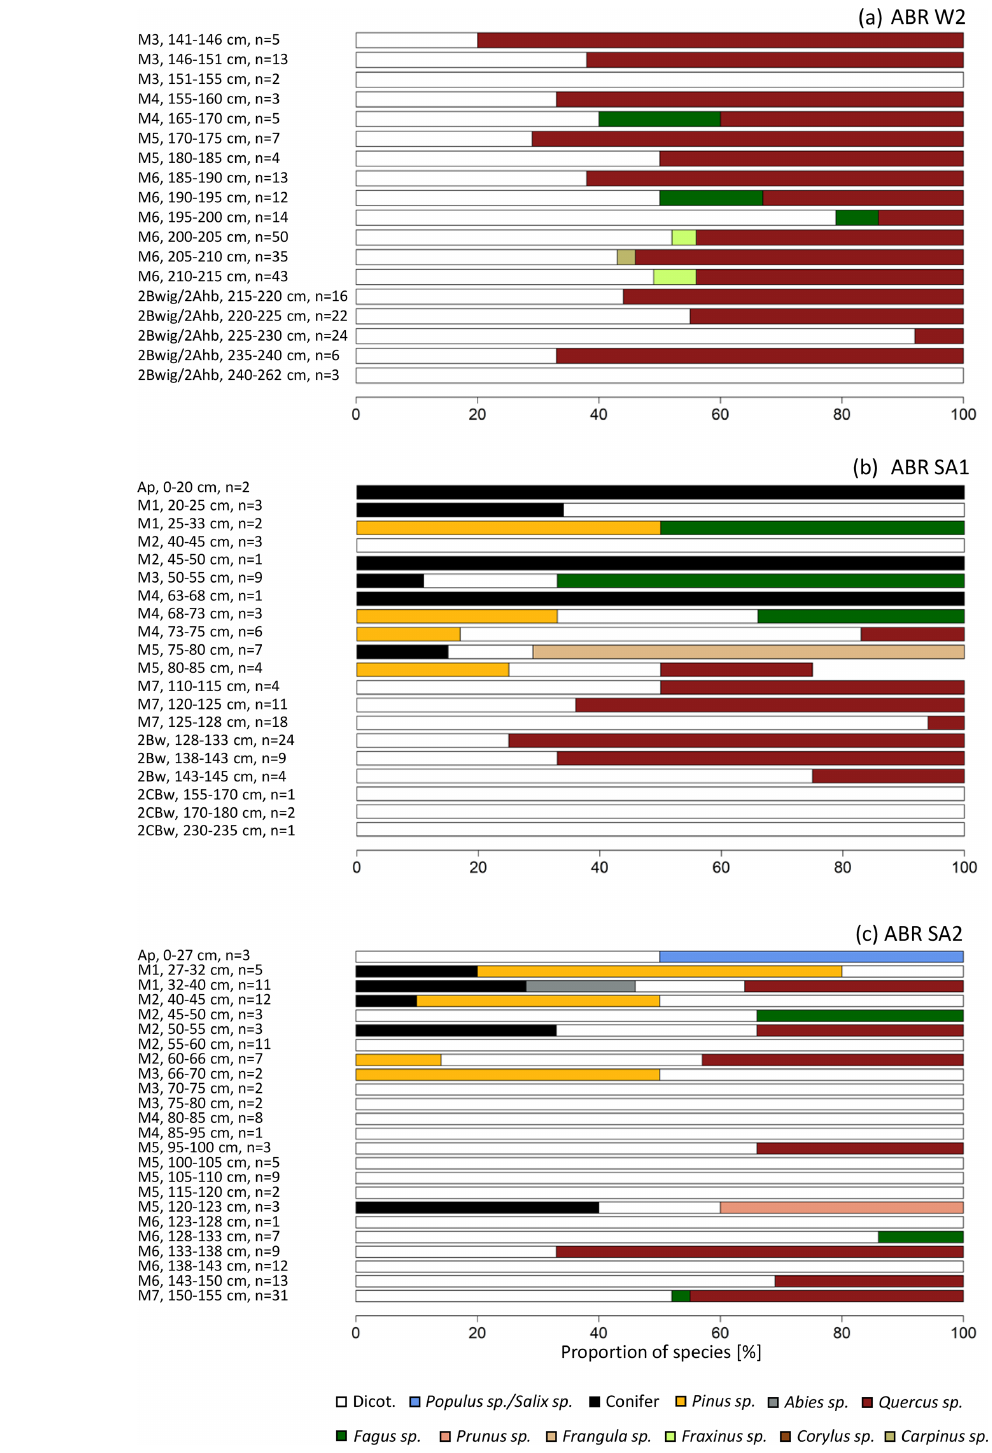
Figure 6. Percentage distribution of charcoal taxa for different sampling depths at the profiles ABR W1 (a) , ABR SA1 (b) and ABR SA2 (c) ( n is the number of identified charcoal fragments). Particle size ranges: 1–2, > 2mm.